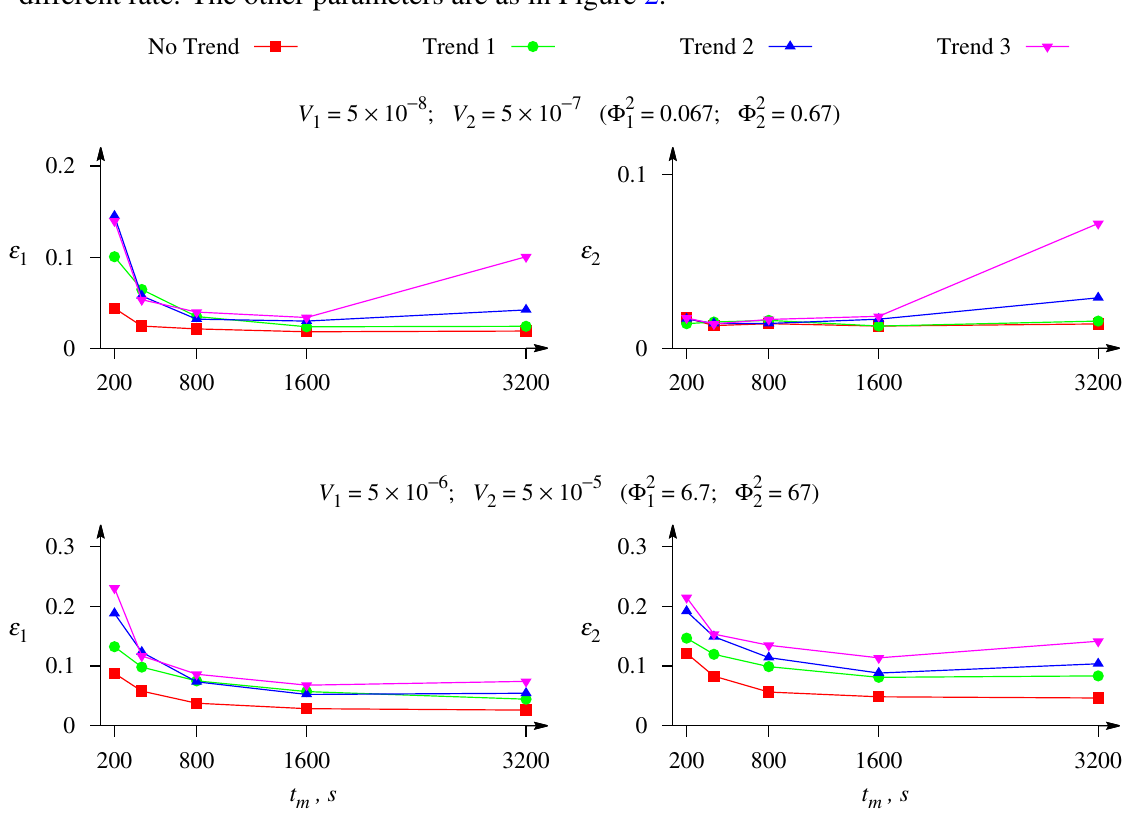
Figure 8. The relative errors, ε of both substrates, S values of the maximal enzymatic rates, V response is affected by white Gaussian noise with σ = 0 . 05 and the exponential trend of a different rate. The other parameters are as in Figure